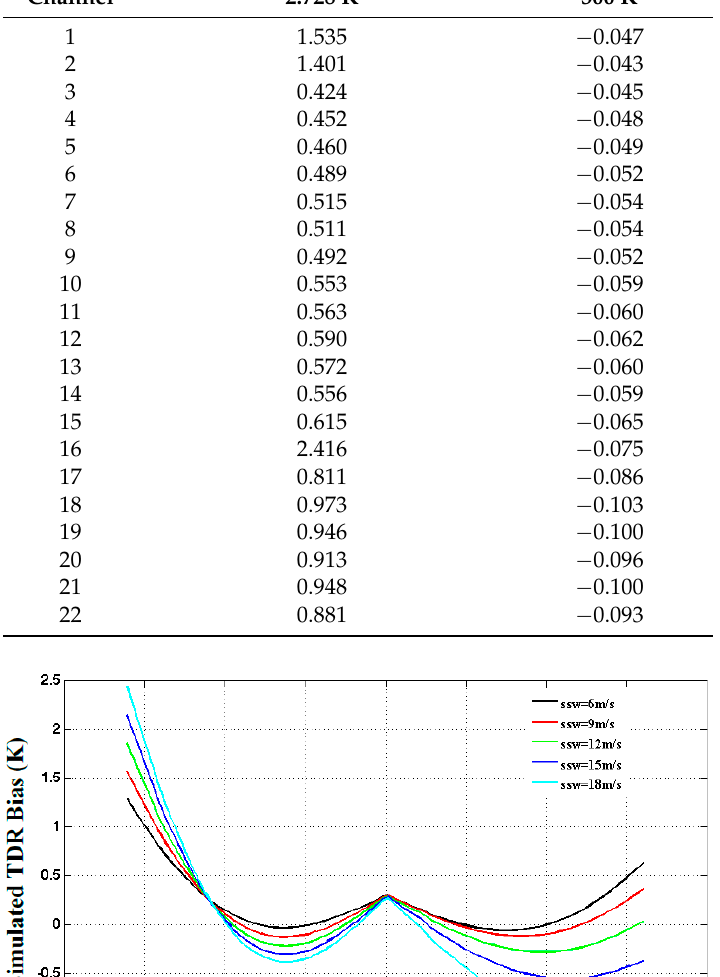
Table 7. Effects of ATMS reflector emission on warm (300 K) and cold (2.728 K) target radiances in terms of brightness temperatures.